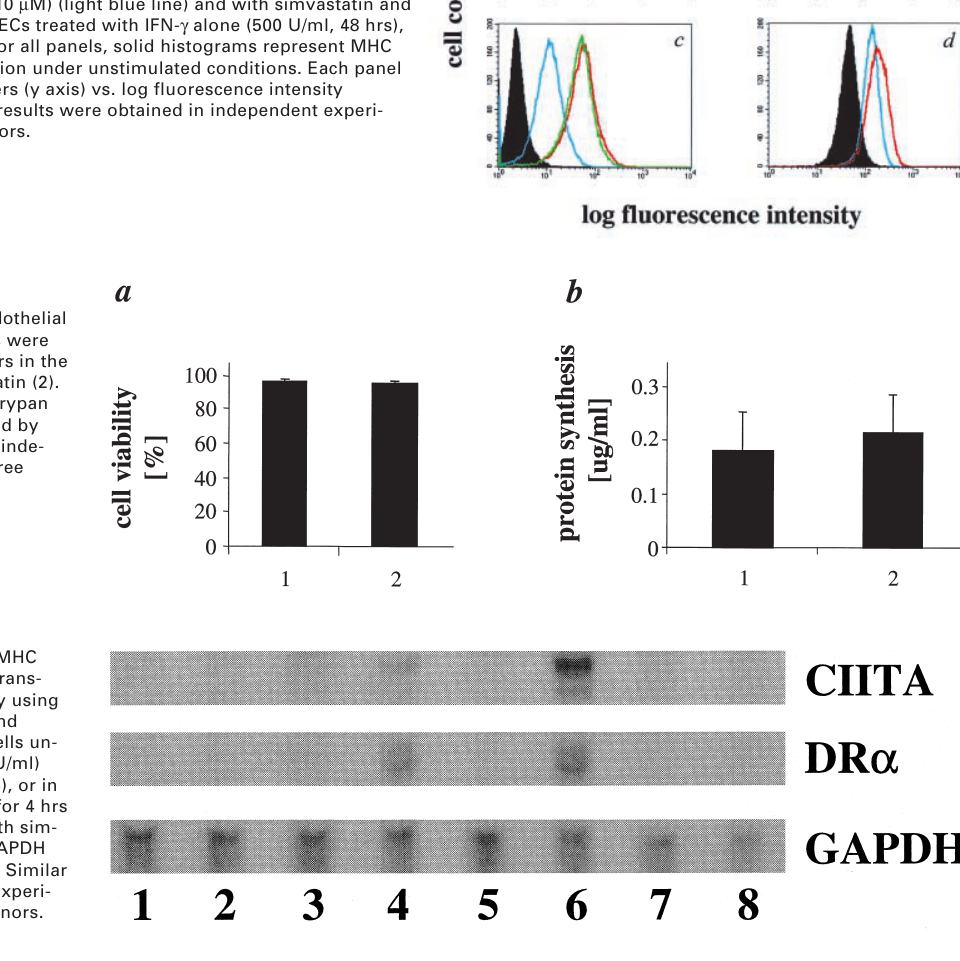
Simvastatin decreases IFN- γ induced MHC class II protein expression on human endothelial cells. Flow cytometric analysis for MHC class II ( a - c ) and MHC class I ( d ). a , Human vascular endothelial cells (ECs) treated with IFN γ (500 U/ml, 48 hrs) alone (red line), or with simvastatin (10 µ M, light blue line). b , ECs treated with IFN- γ (500 U/ml, 48 hrs) alone (red line), or with simvastatin 0.2 µ M (green line), 2 µ M (orange line), or 10 µ M (light blue line). c , ECs treated with IFN- γ alone (500 U/ml, 48 hrs) (red line), or with simvastatin (10 µ M) (light blue line) and with simvastatin and L-mevalonate (500 µ M) (green line). d , ECs treated with IFN- γ alone (500 U/ml, 48 hrs), or with simvastatin (10 µ M, red line). For all panels, solid histograms represent MHC class II ( a - c ) or MHC class I ( d ) expression under unstimulated conditions. Each panel is a histogram representing cell numbers (y axis) vs. log fluorescence intensity (x axis) for 15,000 viable cells. Similar results were obtained in independent experi- ments with ECs from five different donors.